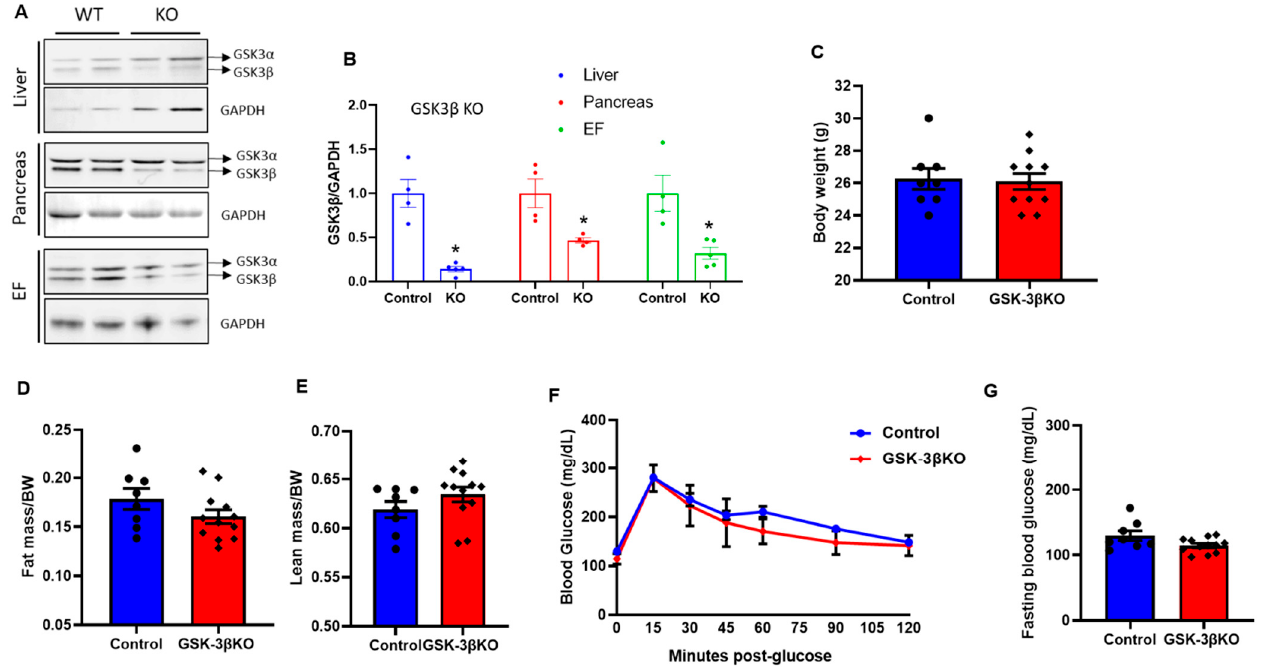
Figure 3. Creation and characterization of global conditional GSK-3 β KO mouse model. ( A ) Repre- sentative immunoblot showing specific deletion of GSK-3 β in the liver, pancreas, and epididymal fat in GSK-3 β KO mice. ( B ) Quantification of GSK-3 β expression from GSK-3 β KO and control tissues showing a significant reduction in GSK-3 β expression in KO mice compared to controls at the termination of the experiment (16 weeks post chow/HFD treatment). The replicates of different samples were analyzed. Baseline body weight ( C ), fat mass ( D ), lean mass ( E ), glucose tolerance test ( F ), and fasting blood glucose ( G ) in controls and GSK-3 β KO mice; * p < 0.05 WT vs. KO.